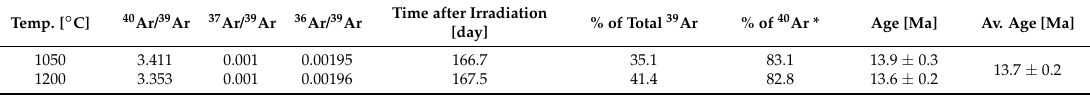
Table 2. Results of radiometric 40 Ar/ 39 Ar dating on biotite crystals from the Sl ă nic tuff. Temp. [ ◦